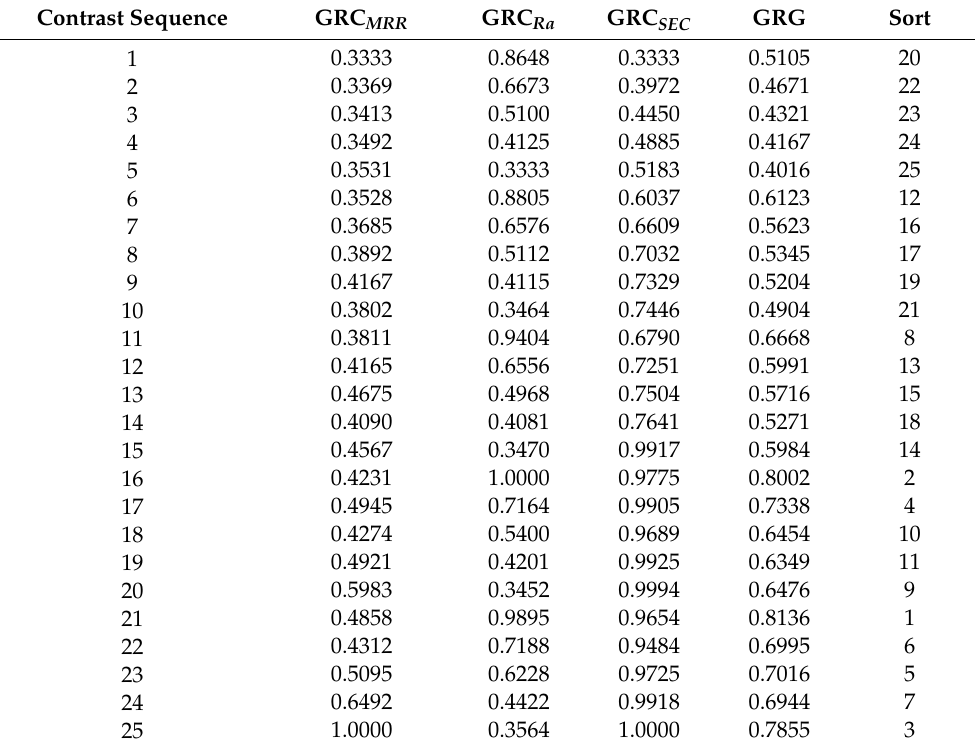
Table 6. Results of grey relational